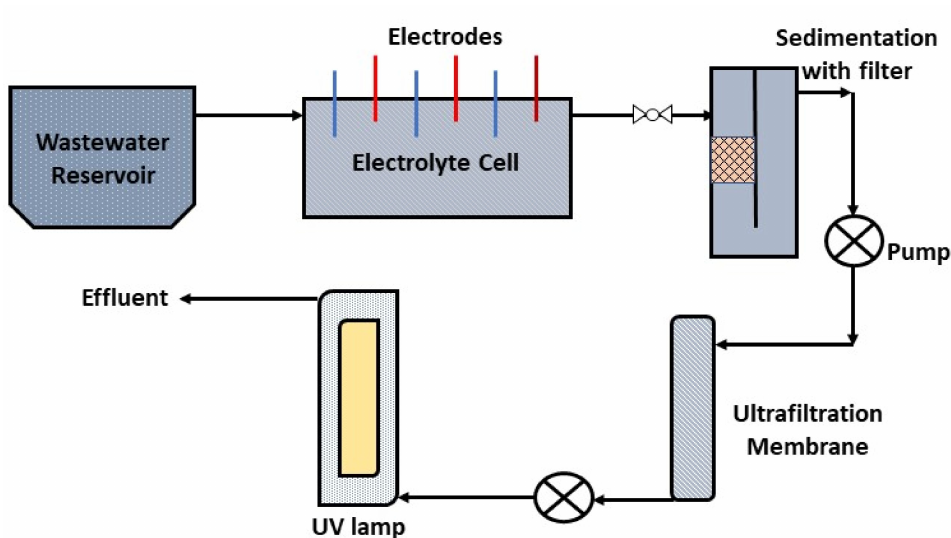
Figure 3. Combined electrocoagulation, ultrafiltration, and photodegradation system for SWW (modified from Meiramkulova et al. 2019)